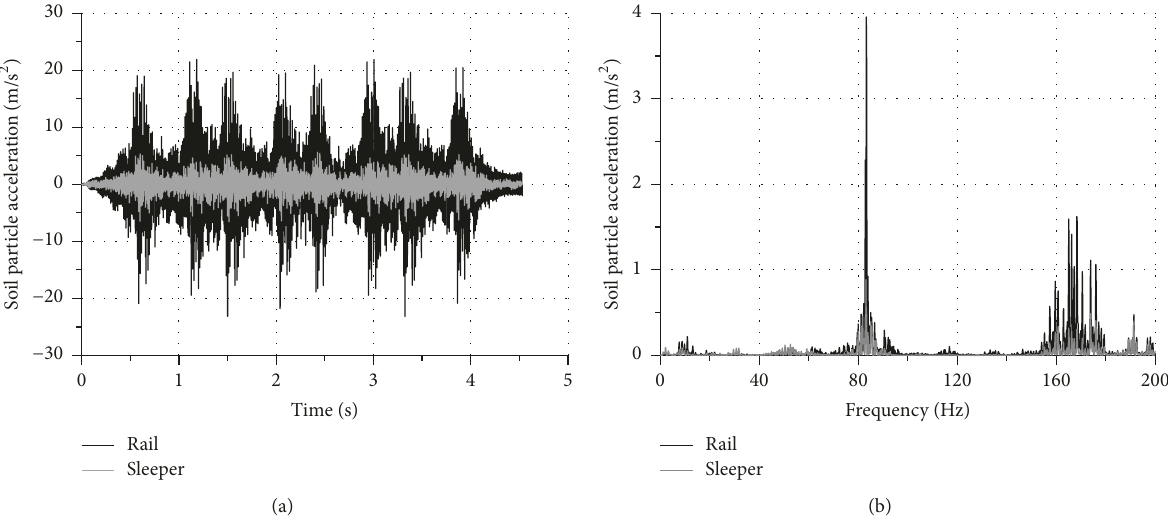
Figure 6: Vertical acceleration comparison between the model (grey) and field data (black). Results obtained on the rail (a) and over a sleeper (b).